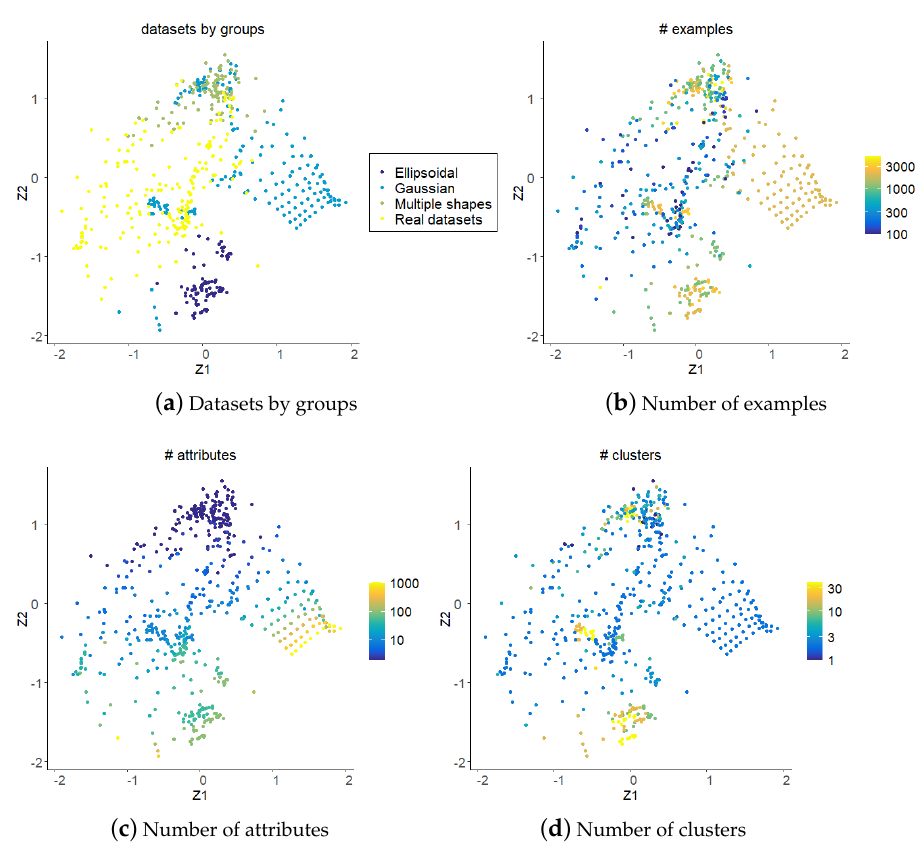
Figure 8. Characteristics of the datasets projected in the instance space after the inclusion of real datasets, color coded according to ( a ) distribution of the datasets by groups, ( b ) number of examples, ( c ) number of attributes and ( d ) number of clusters represented by ground truth. The characteristics have been log 10